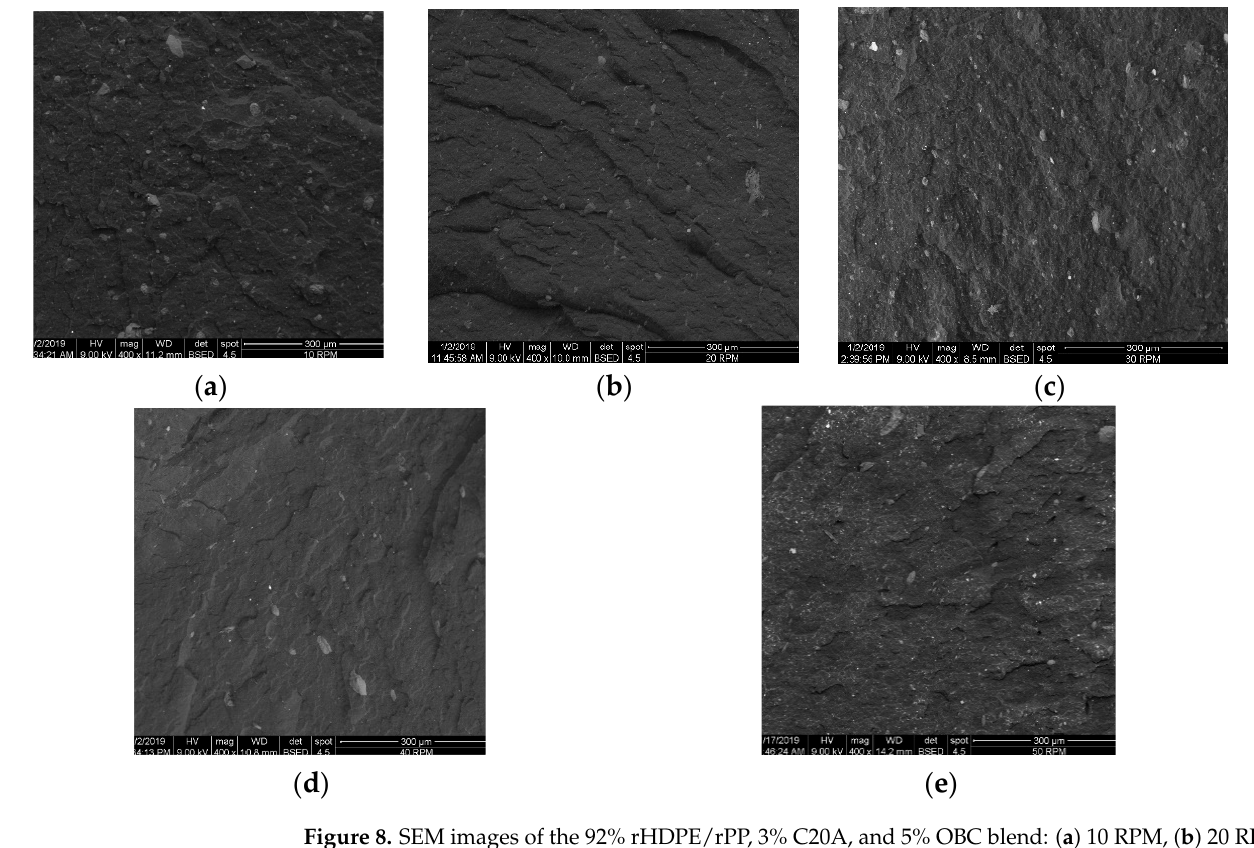
Figure 7. SEM images of the 97% rHDPE/rPP and 3% C20A blend at different screw speeds ( a ) 10